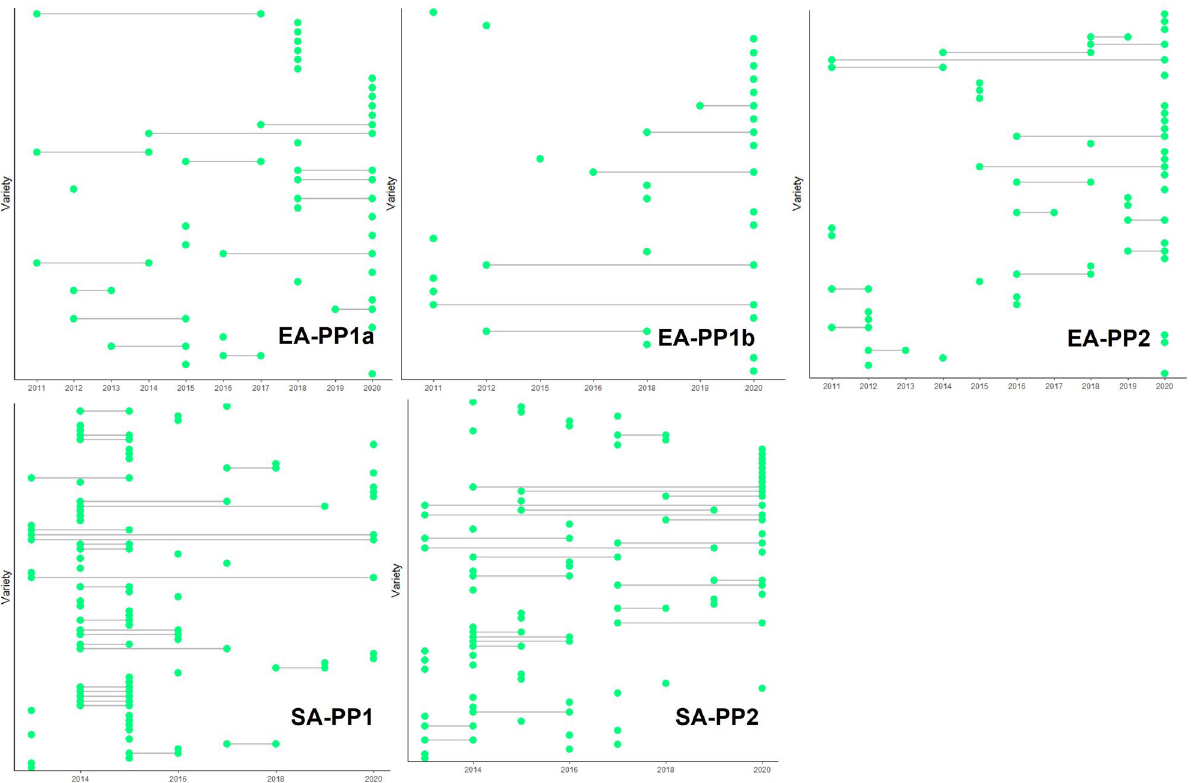
Figure 5. Presence of checks (both commercial and internal genetic gain) across years in the five breeding pipelines in eastern and southern Africa during the period used for genetic trend